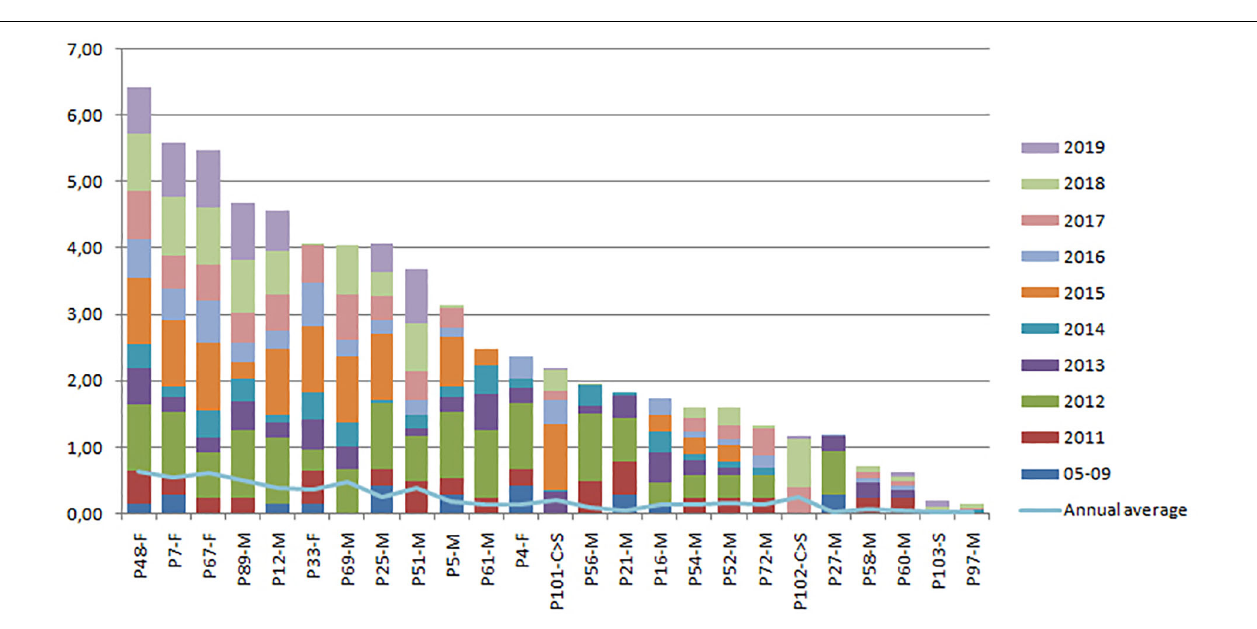
had one calf, two have three calves, and one had two. The average annual crude birth rate in the El Morro was 23% higher (0.068, SD = 0.05) ( Table 4